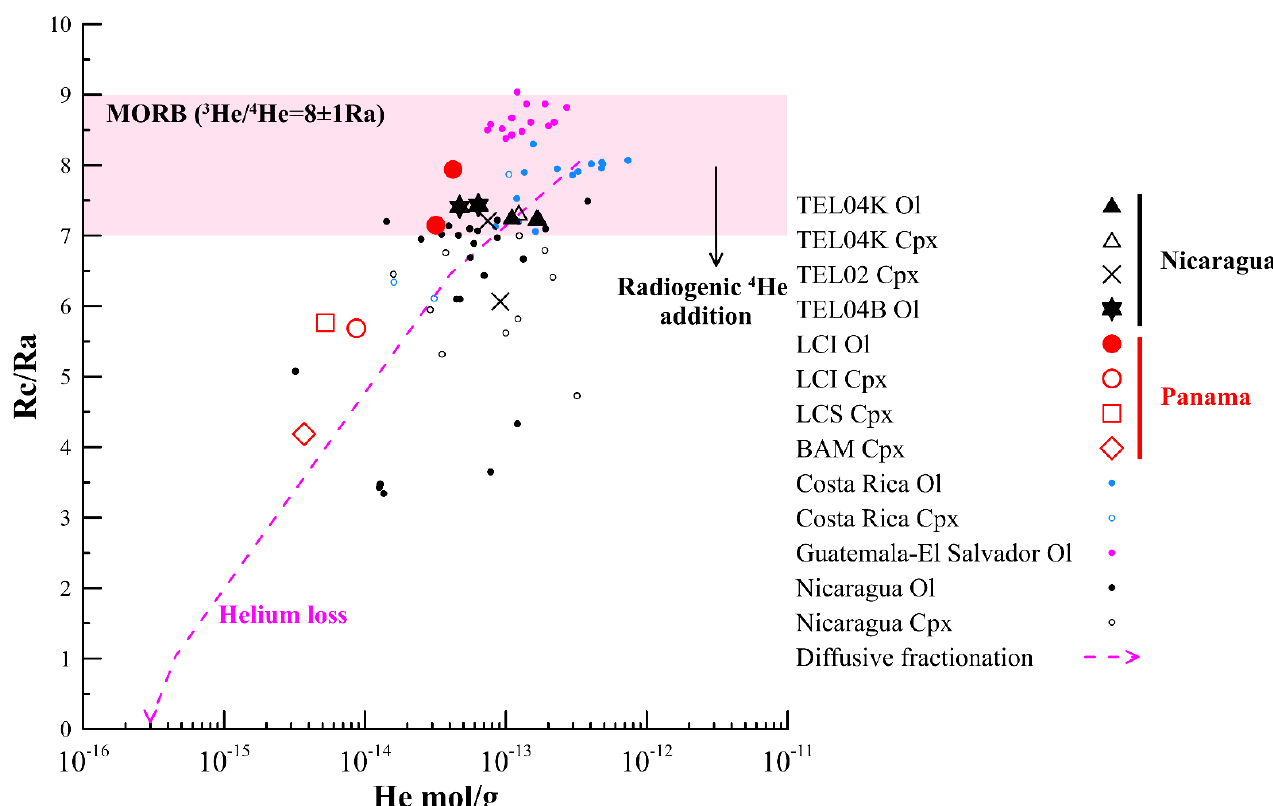
Figure 2. He concentration in fluid inclusions (FI) in mol/g versus air-corrected 3 He/ 4 He (Rc/Ra) ratio. Data of FI hosted in olivine (Ol) and clinopyroxenes (Cpx) are distinguished for the Telica (black symbols) and Baru (red symbols) samples. Additional data of FI along CAVA are reported for comparison [38,46,54,62,63,72] and distinguished (with different colors) per mineral phase and arc ‐ segment. Due to the presence of a few data and their vicinity, Guatemala and El Salvador are considered and discussed in the text as a unique segment. More details on the source data are reported in the Supplementary Table S4. Mid Ocean Ridge Basalt (MORB) range of 3 He/ 4 He is from [87]. The pink dashed line represents the path of diffusive fractionation due to helium loss from the crystals, taking into account the diffusion coefficient (D) of 3 He and 4 He (D 3He /D 4He = 1.15 in solid mantle; see [79] for more details). Starting magmatic composition is: 4 He = 3 × 10 − 13 mol/g and 3 He/ 4 He = 8.0 Ra. These values were chosen considering mean compositions of Costa Rican Ol FI, only to show the behaviour of the expected path.